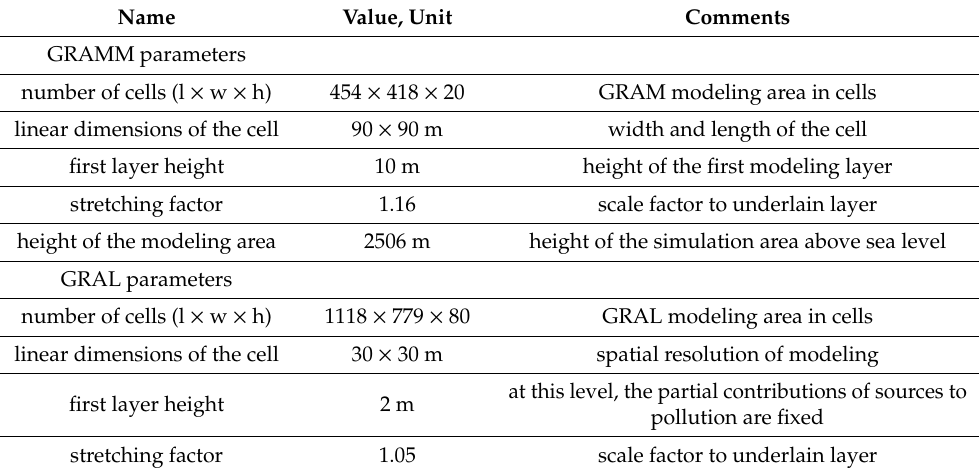
Table 2. Simulation volume